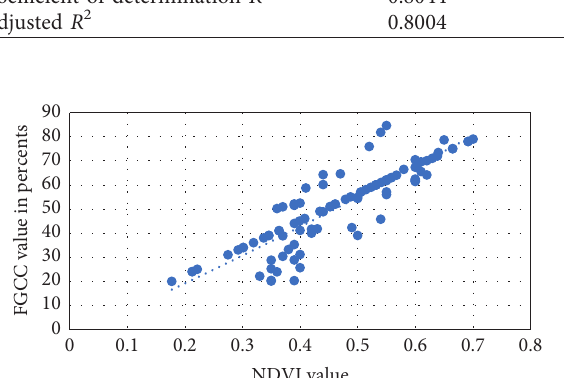
Figure 9: Approximation of the polynomial model for NDVI into FGCC conversion for millet.